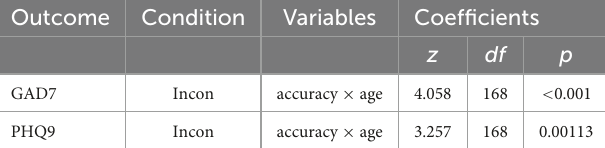
TABLE 8 Generalized linear models of mood scores and associated interactions for Visual Search conditions. Outcome